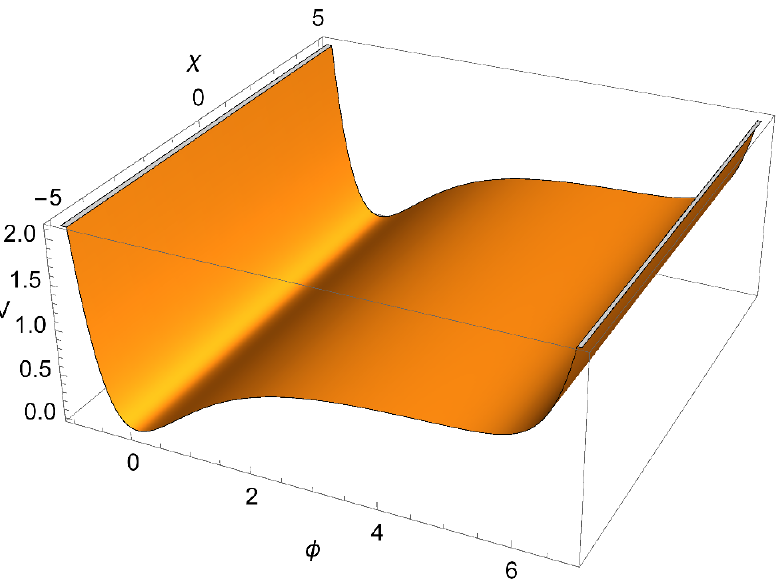
Figure 4 . The scalar potential for (cid:30) and (cid:31) for the deformed